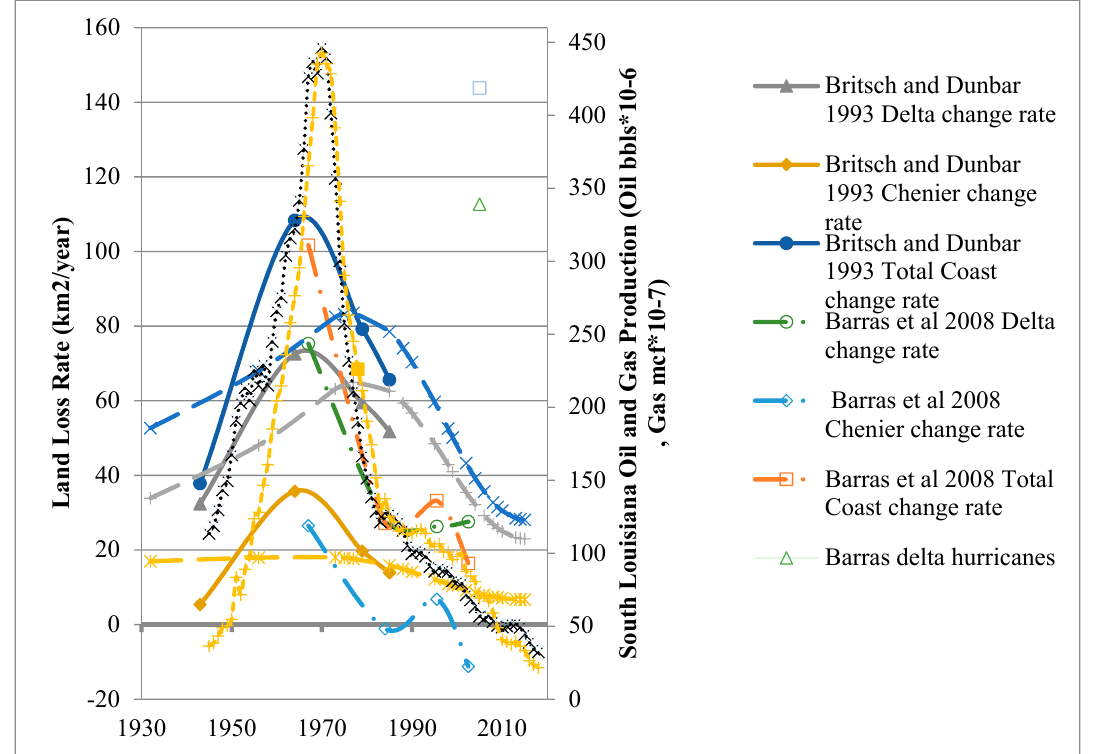
Figure 7. Oil and gas production and land loss studies for coastal Louisiana. Loss values are from [32,34,44] where rate values represent an average over the time interval shown. Production data are from Louisiana Department of Natural Resources. These historical data show close temporal and spatial correlations between rates of wetland loss and rates of hydrocarbon